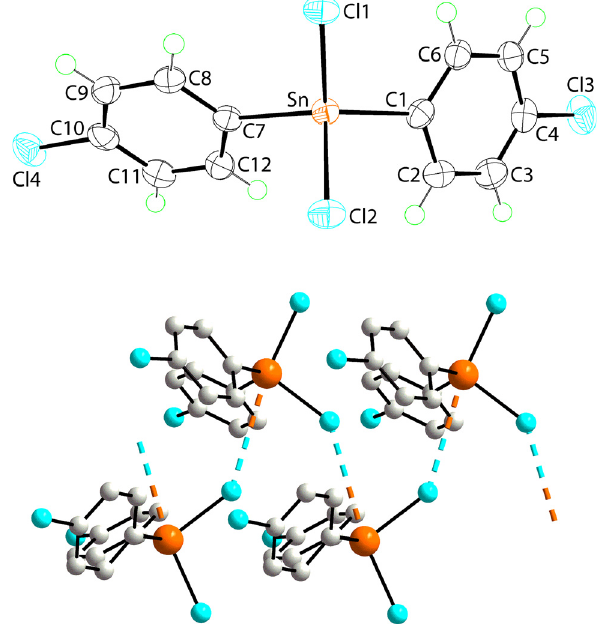
Table 1 contains crystallographic data and Table 2 contains the list of the atoms including atomic coordinates and displacement parameters.